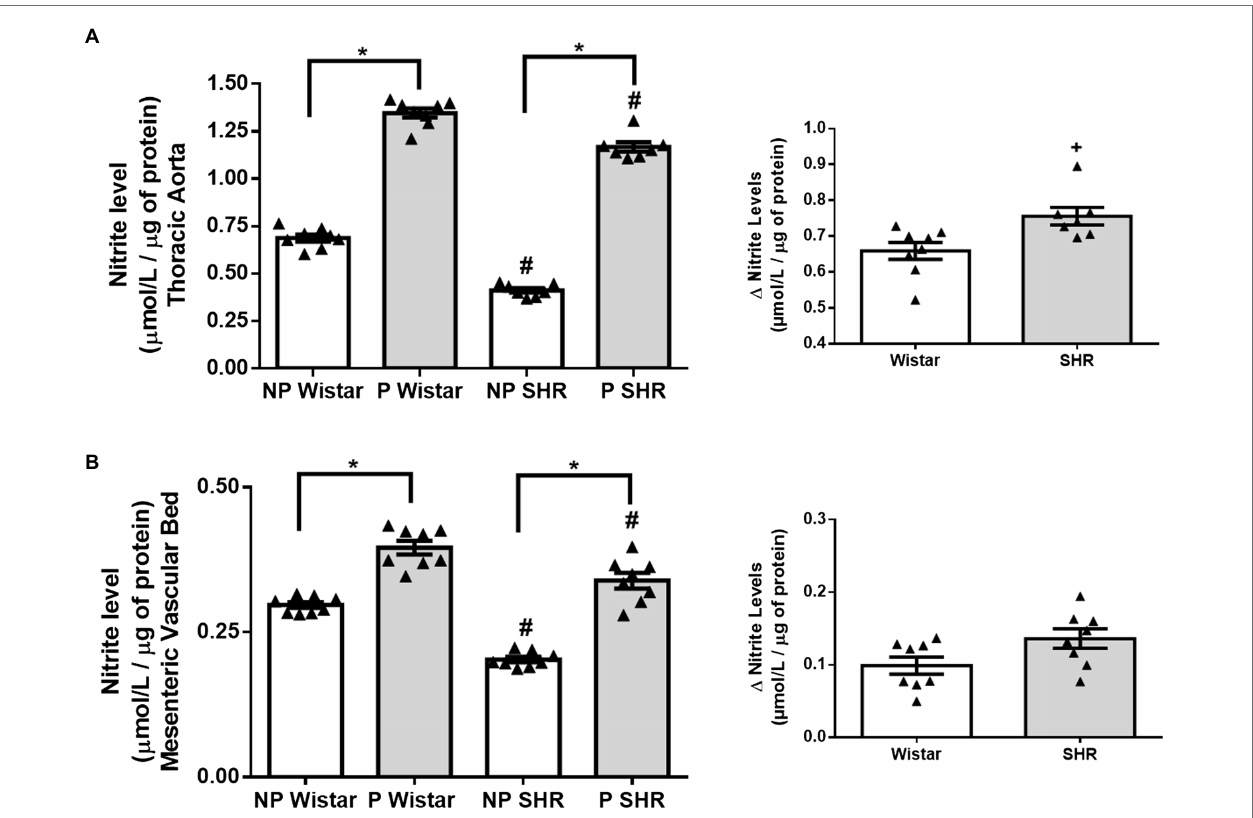
FIGURE 1 | Nitrite levels ( μ mol/L/ug of protein) and calculation of variation ( Δ ) of nitrite levels in aortic (A) and mesenteric vascular bed (B) of non-pregnant (NP) and pregnant (P) Wistar and spontaneously hypertensive (SHR) rats. The data represent the mean ± SEM of the results ( n = 7–8). * p < 0.05 P versus NP groups; # p < 0.05 NP SHR and P SHR versus NP Wistar rats and P Wistar rats; + p < 0.05 SHR versus Wistar